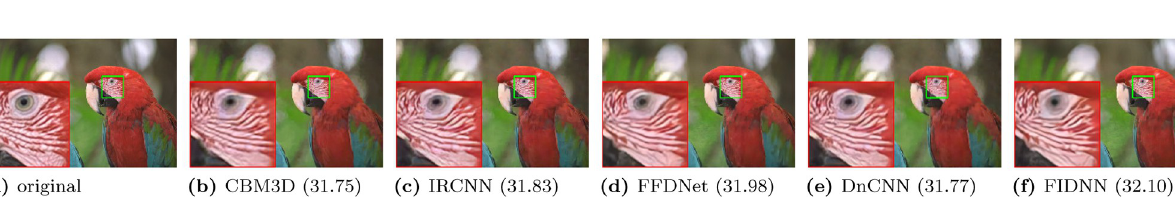
PLOS ONE | https://doi.org/10.1371/journal.pone.0276373 November4, 2022 10 /